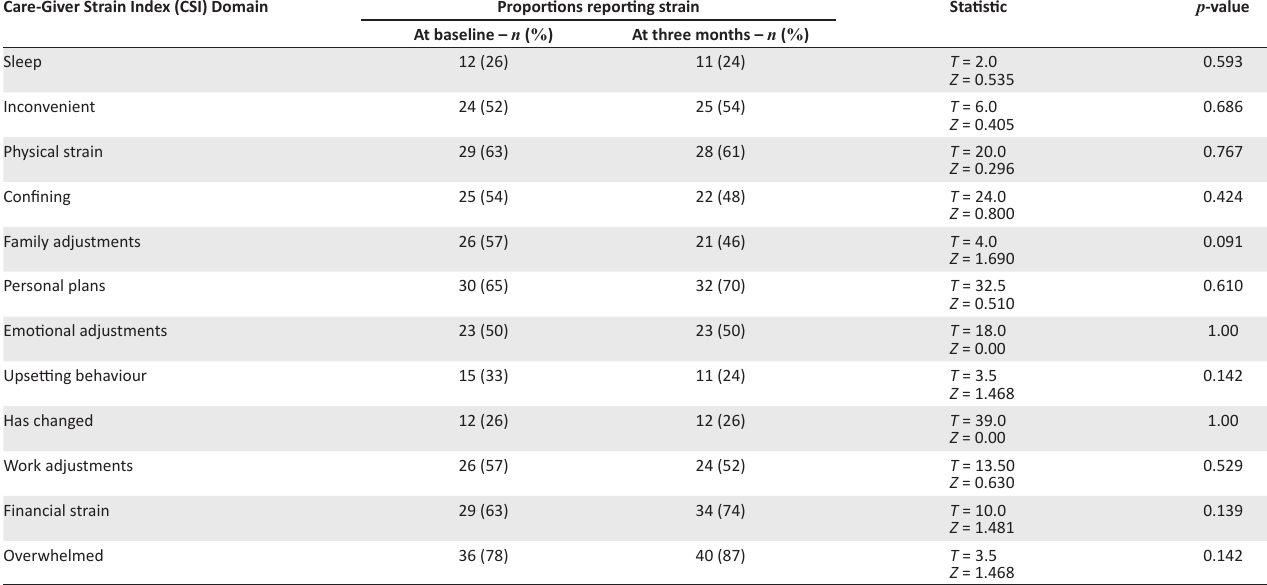
TABLE 2: Proportion of caregivers reporting caregiver strain ( n = 46).